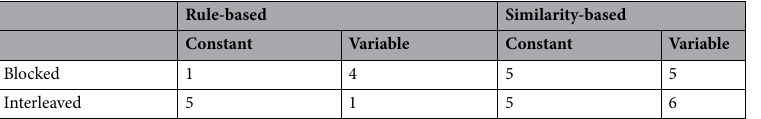
Table 3. Frequency and presentation order of the 32 participants who were excluded from the analyses of the transfer phase. Eighteen participants did not reach the learning criterion, plus 14 participants were excluded because considered as outliers (among the 14 participants, 11 pressed the key associated with Category B less than 10% of the trials, and three participants pressed no key on more than 15% of the trials.